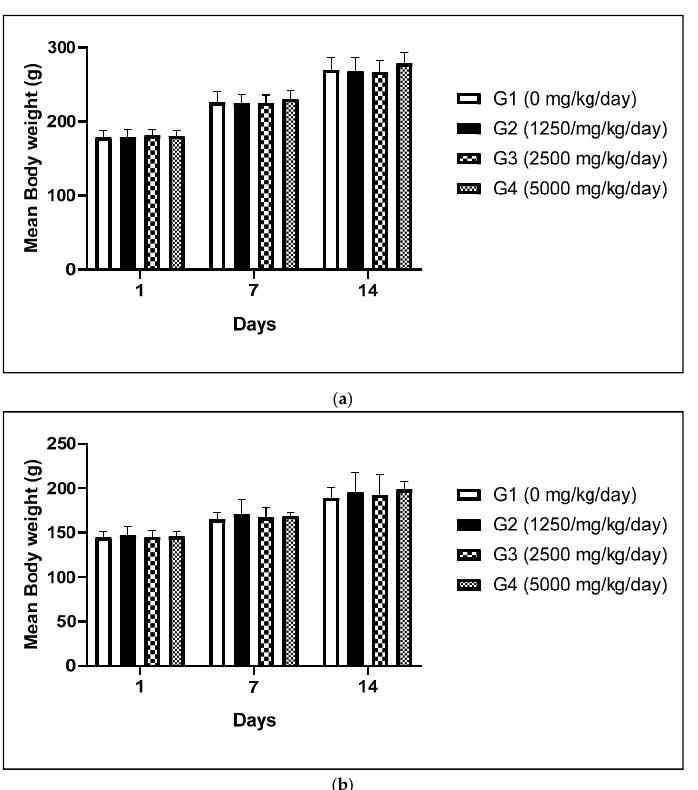
Figure 1. Mean body weight of male ( a ) and female ( b ) rats administered with frpfdZAL for 2 weeks. Each value represents the mean ± standard deviation ( n = 5). ( a ) male; ( b ) female.